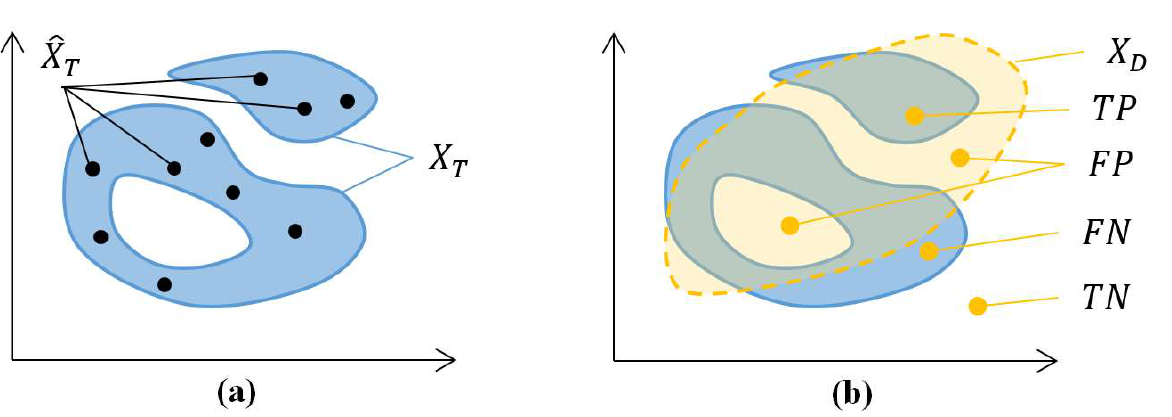
Figure 2. Target class area ( a ) and deformed area ( b ).